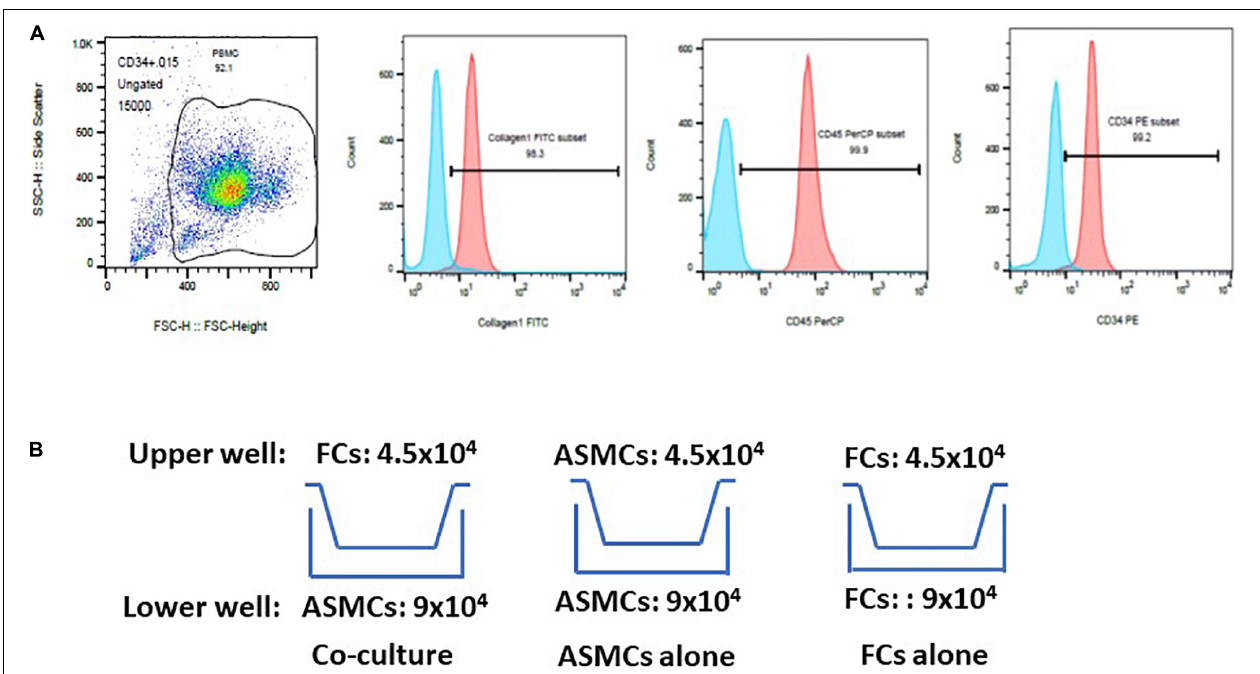
FIGURE 1 | Purification of fibrocytes (FCs) after culturing cells for 5–7 days. (A) Cells underwent triple positive staining ( > 90% positive expression) for collagen-I, CD34 and CD45 via flow cytometry. The proportion of positive expression was defined by isotype staining. (B) Co-culture model of airway smooth muscle cells (ASMCs) with FCs. Co-culture: ASMCs in lower well and FCs in upper well were cultured at a cell ratio of 2:1 for 48 h. ASMCs alone were cultured in the lower and upper well at a cell ratio of 2:1 as a major control. FCs alone were cultured in the same way. Culture supernatant and cell lysates was collected from lower wells for analysis.